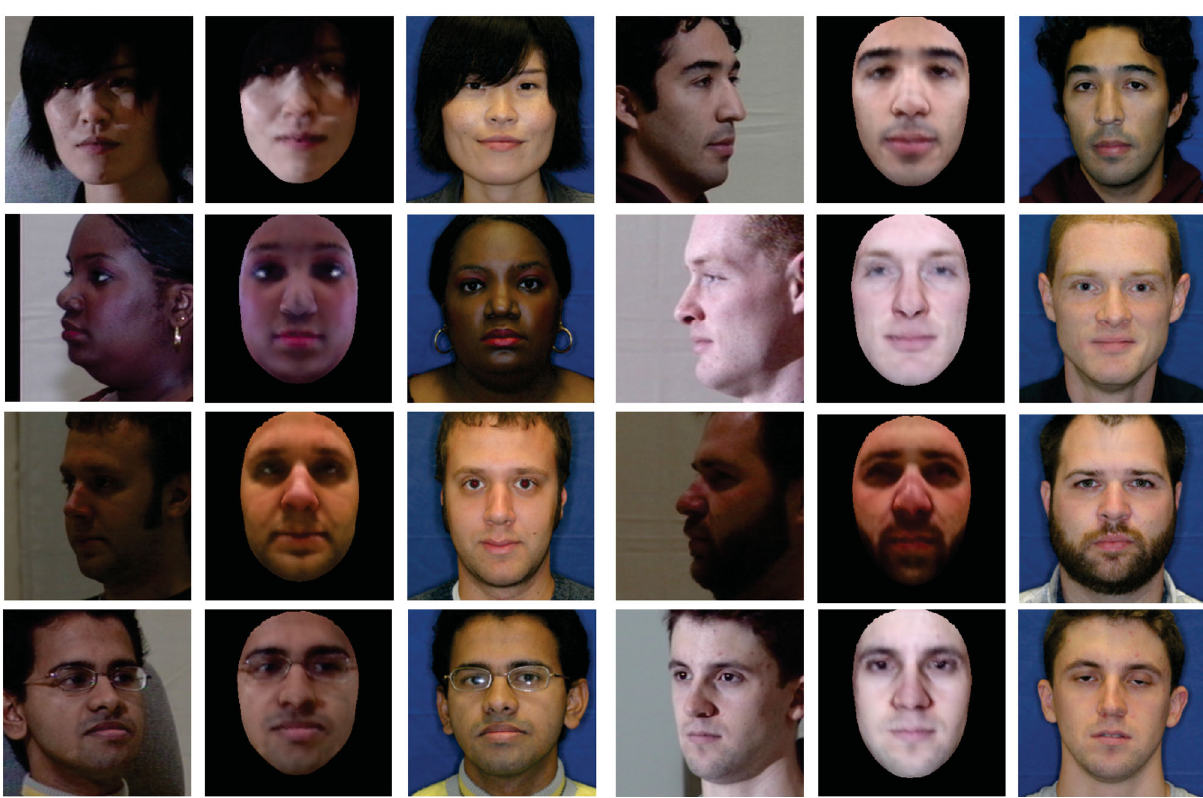
Fig. 7 Example frontalization results on the Multi-PIE dataset. Each triple, left-to-right: original face image, frontalized face, ground-truth frontal face.